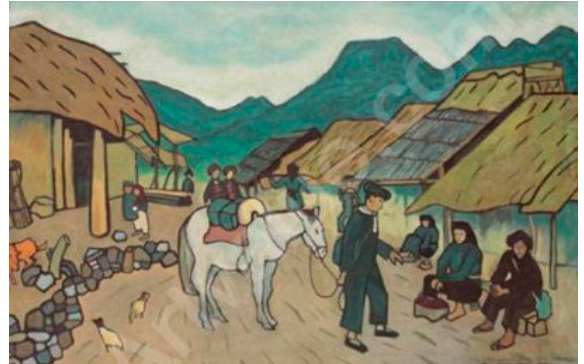
Figure A14. Canh pho Nguyen Binh —Bui Xuan Phai. Auctioned at Sotheby’s, April 2008. The images were sourced from Tuoi Tre Newspaper (Ly 2008).